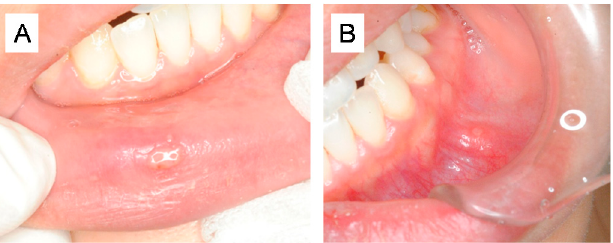
Figure 3. Therapeutic effect of Hangeshashinto on stomatitis. ( A ): Before Hangeshashinto treatment; ( B ): After Hangeshashinto treatment.